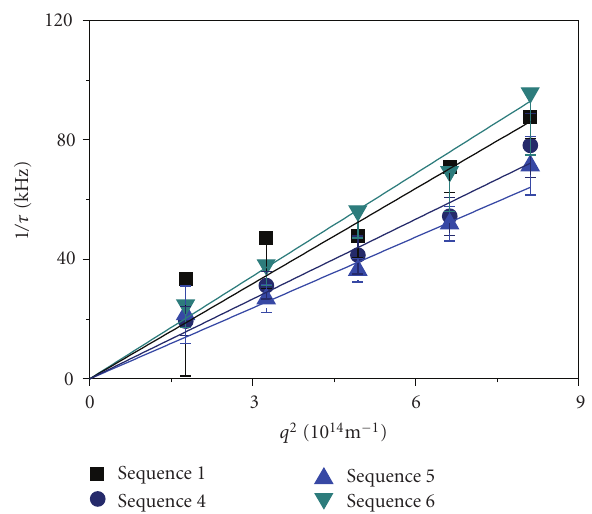
Figure 4: Dispersion relation of the fast di ff usive mode for dialysed solutions of sequences 1, 4, 5, and 6 at T = 24 ◦ C. Solid lines are fits to (4). Error bars were obtained by fitting experimental correlation functions g 2 ( t ) to (1) taking into account (2).